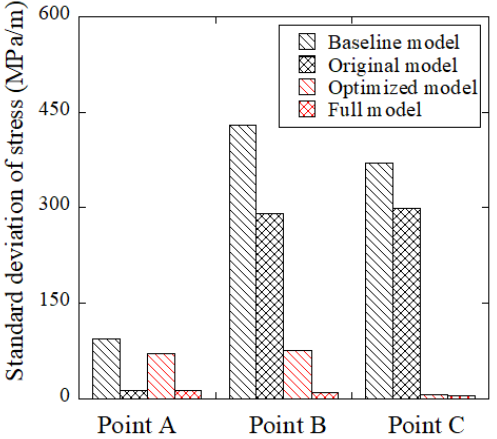
Figure 18. Standard deviation of normalized stress at the points A, B, C for the baseline, original, optimized and full models in the irregular wave ( H = 0.195 m, T = 2.16